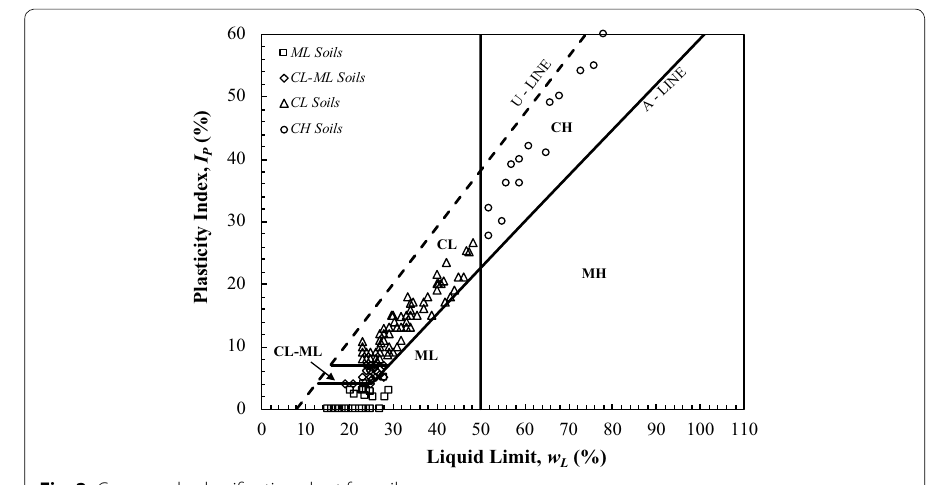
Fig. 2 Casagrande classification chart for soils